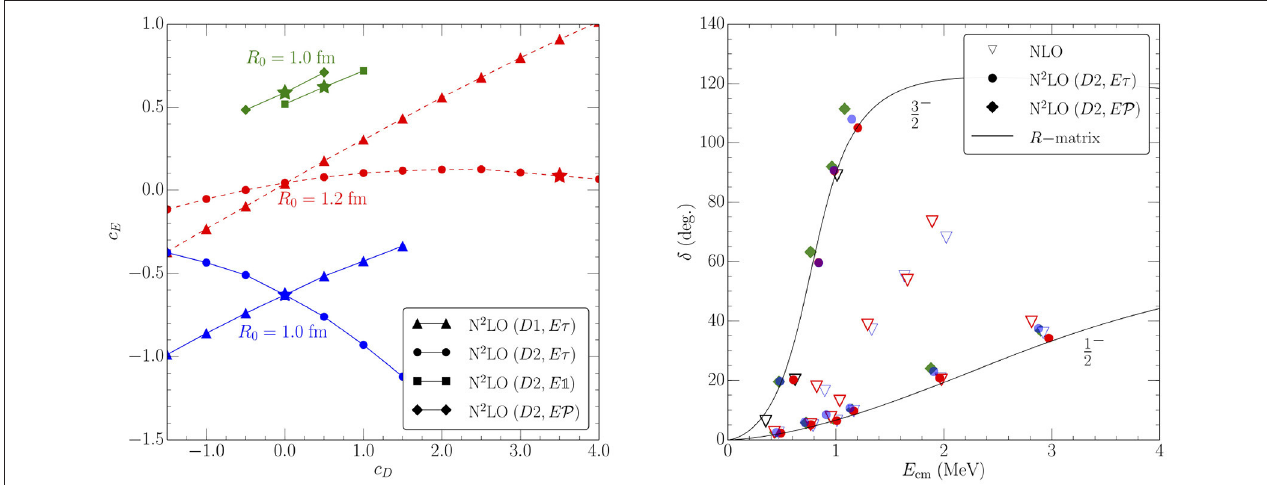
FIGURE 3 | (Left) Parameter curves for the LECs c D and c E for the binding energy of 4 He for different cutoffs and 3 N parameterizations discussed in section 4. (Right) Reproduction of n- α P wave phase shifts at NLO and at N 2 LO for the parameter combinations marked by a star in the left panel. Figures taken from Lynn et